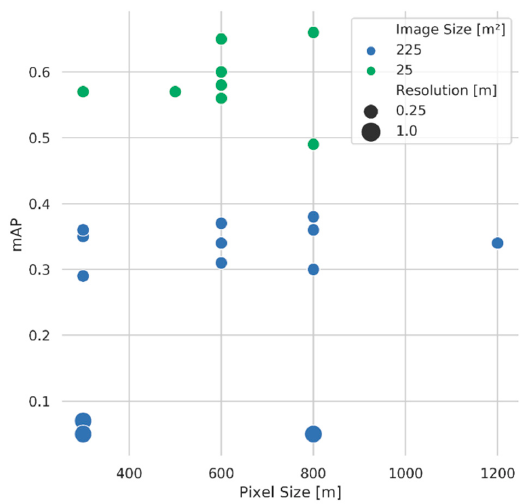
Figure 3. Training results of the different models. Image size refers to the width and height of the backscatter mosaic tiles. Pixel size refers to the pixel count each mosaic tile is upscaled to prior to training with the neural network. The mean average precision (mAP) represents the model performance on the validation dataset.